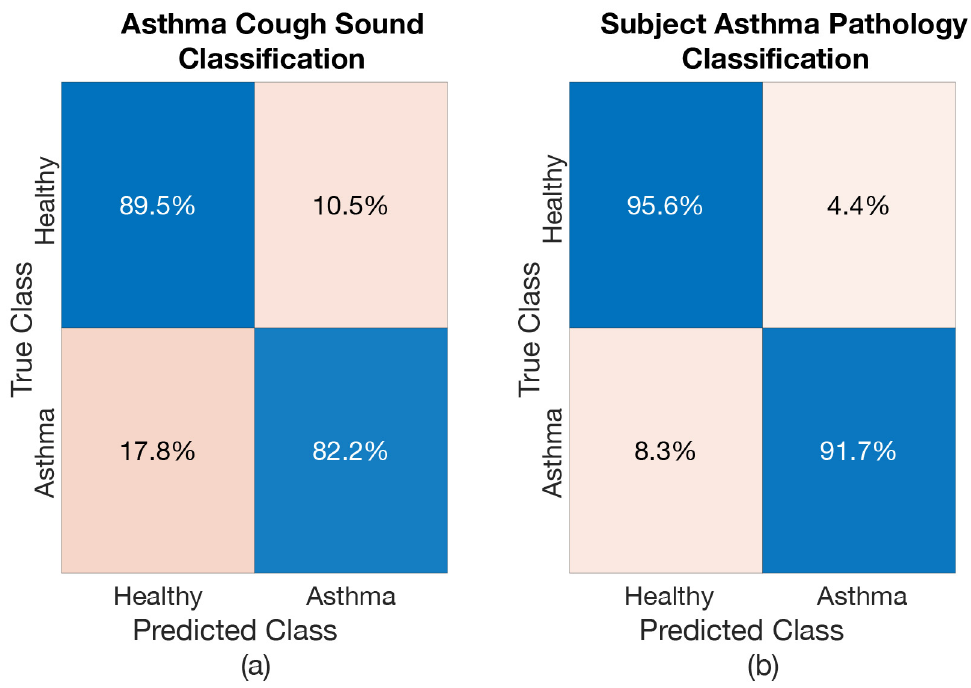
Figure 10. Confusion Matrix of Healthy vs. Asthma Model : ( a ) when classifying Asthmatic coughs, ( b ) when classifying subject for Asthma.